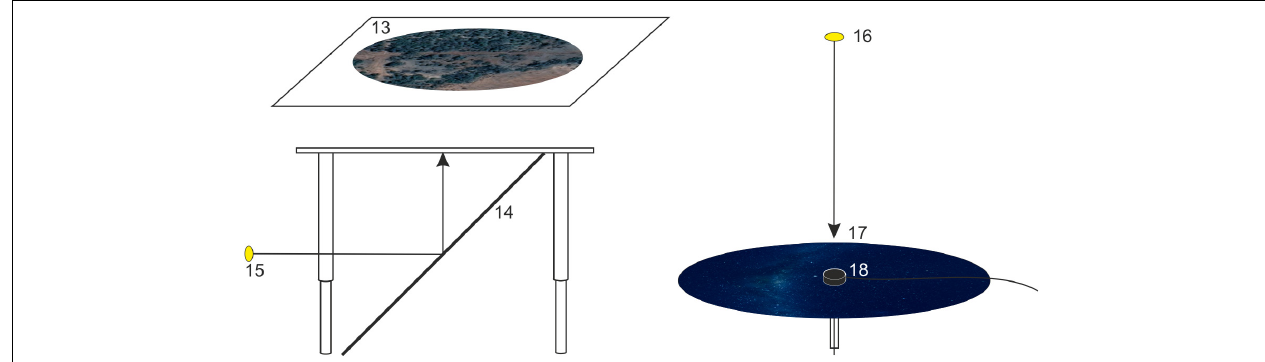
FIGURE 3 | A schematic drawing showing how optic flow (left) and an austral starry night sky (right) are projected onto the experimental arena. Moving optic flow (a satellite image of the Australian countryside) is projected from a projector placed to the side of the table (15), via a 45 ◦ mirror (14), onto the underside of a diffusing screen (13) placed on the tabletop under the behavioral arena. A local starry night sky (generated using the planetarium software Stellarium) is projected from a projector mounted above the arena (16) onto a circular diffusing screen (17) placed on top of the arena (which also holds the encoder mount (18) at its